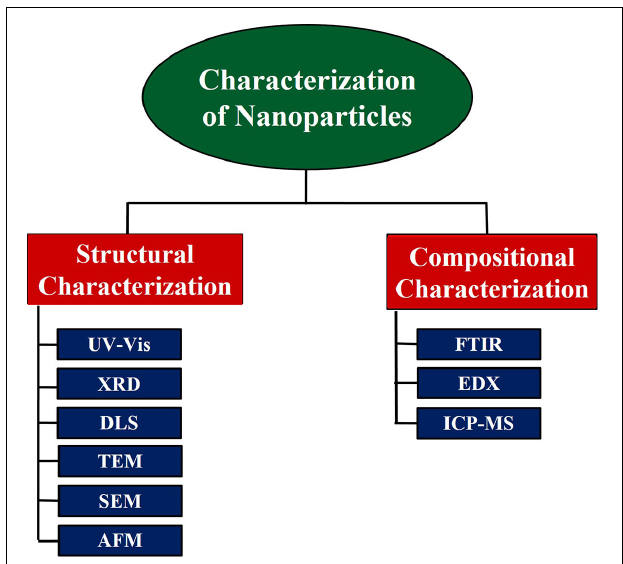
FIGURE 2 | Characterization methods for nanoparticles: several analytical techniques are employed to isolate and characterize monodisperse nanoparticles. UV–Vis, ultraviolet–visible spectroscopy; XRD, X-ray powder diffraction; DLS, dynamic light scattering; TEM, transmission electron microscopy; SEM, scanning electron microscopy; AFM, atomic force microscopy; FTIR, Fourier transform infrared spectroscopy; EDX, energy-dispersive X-ray spectroscopy; ICP-MS, inductively coupled plasma mass spectrometry.